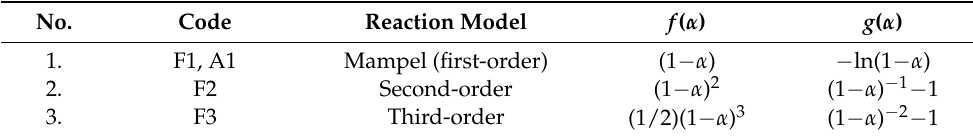
Table 1. The kinetic models used in this study